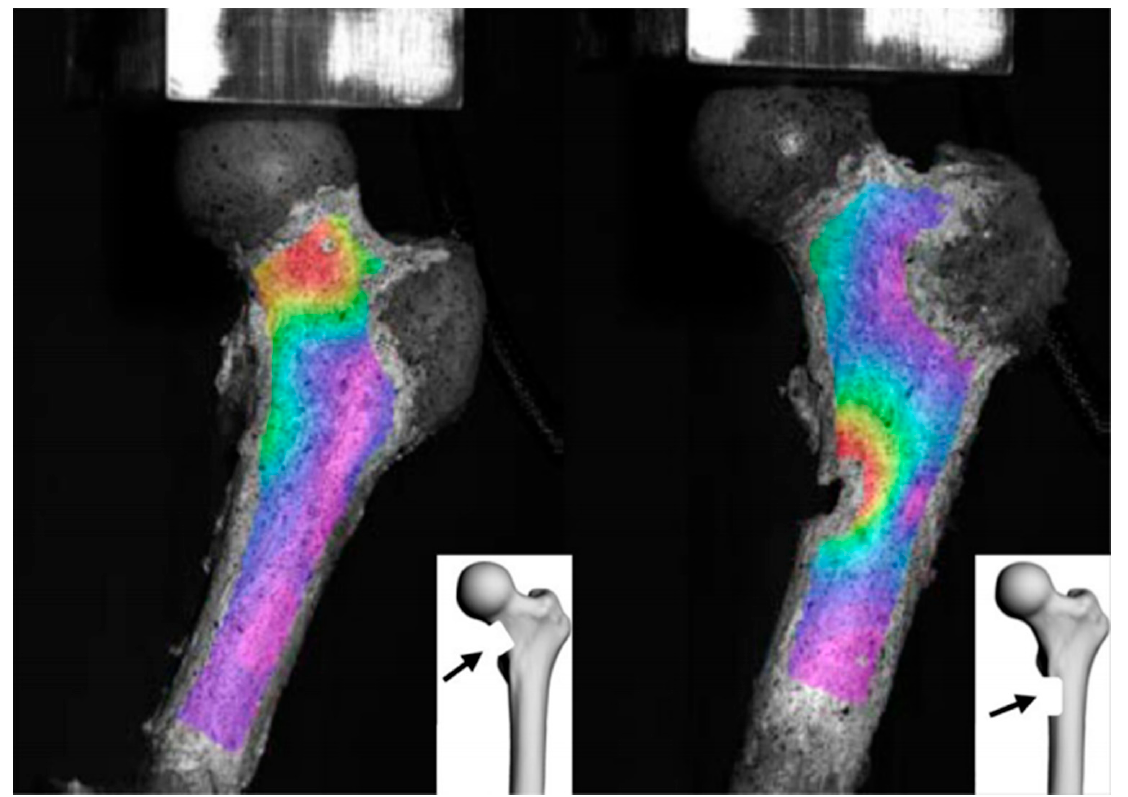
Figure 2. Von Mises strain analysis. Defect on the medial femoral neck ( left ), and under the lesser trochanter medial cortex ( right ) (from Riglet et al. [84], CC-BY-SA 4.0).